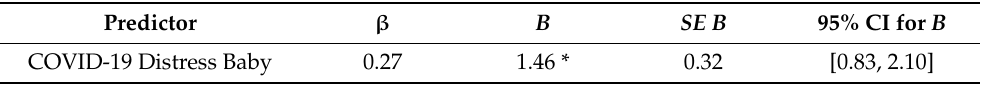
Table 2. Linear Regression Analysis Predicting Antenatal Depression Symptoms from COVID-19 Related Distress in relation to having a baby and overall ( N =